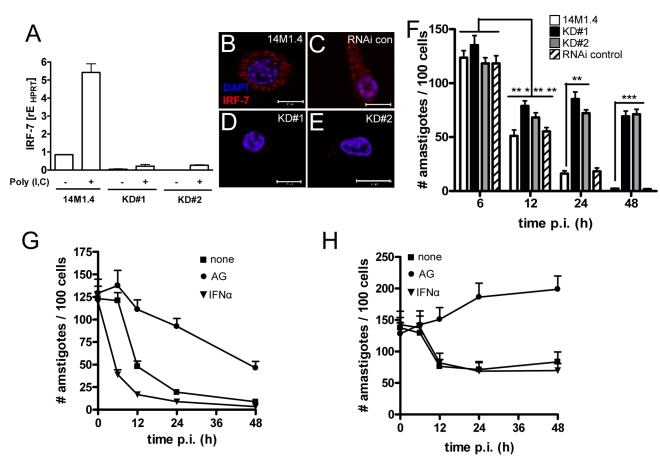
IRF-7-dependent killing of Leishmania in 14M1.4 cells.(A) Silencing of Irf-7 in 14M1.4 cells using lentiviral shRNA generated two clones (KD#1 and KD#2) with >95% knockdown in mRNA accumulation after poly(I:C) induction. (B–E) IRF-7 expression in untreated wild type 14M1.4 (B), in RNAi-control 14M1.4 cells (C) and in KD#1 (D) and KD#2 (E) clones. (F) Wild type 14M1.4 cells (open bars), RNAi control 14M1.4 cells (hatch bars), KD#1 (black bars) and KD#2 (grey bars) cells were infected with L. donovani and the parasite load per 100 cells was determined at the times indicated. *, p<0.05, **, p<0.01, ***, p<0.005 comparing 14M1.4 and knock-down clones. (G and H) 14M1.4 (G) and KD#1 (H) cells were treated with aminoguanidine (circle) or exogenous IFN-α (invert triangle) or untreated (square) then infected with L. donovani. Infection was determined from replicate cultures at times indicated. Scale bars; 10µm.